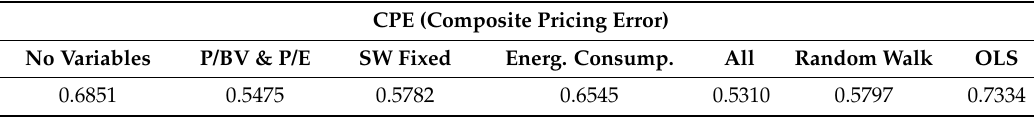
Table 5. Result: composite pricing